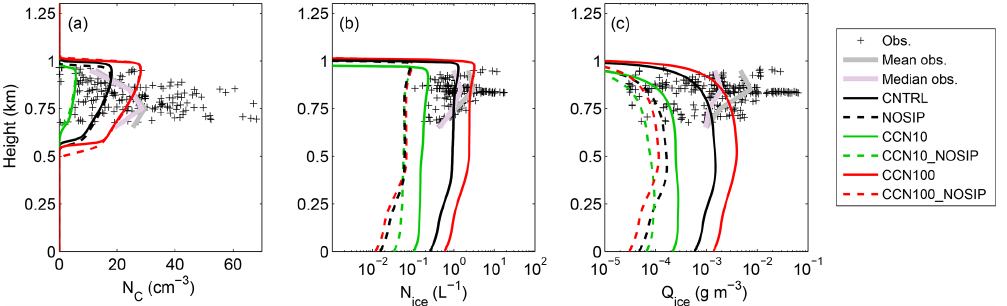
Figure 7. Vertical profiles of (a) cloud droplet concentrations (cm − 3 ), (b) ice crystal concentrations (L − 1 ) and (c) ice mass mixing ratio (gm − 3 ) for the LES sensitivity simulations with varying N CCN . Black, green and red solid (dashed) lines represent CNTRL (NOSIP), CCN10 (CCN10_NOSIP) and CCN100 (CCN100_NOSIP) runs, respectively. The results are averaged between 4 and 8h of simulation time. Black crosses represent the observations, while the solid grey lines show the median observed